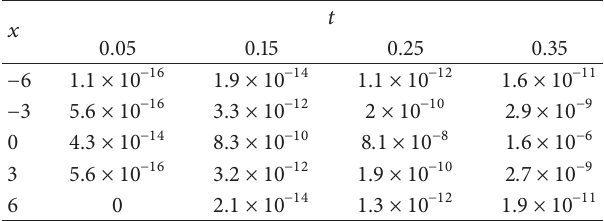
(𝑥,𝑡)| for STO equation with app